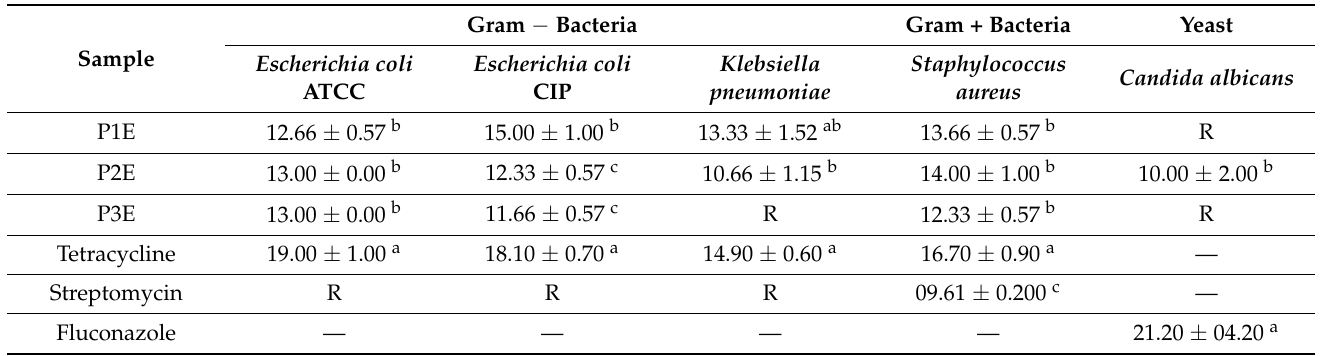
Table 1. Diameter of inhibition zones of P1E, P2E, P3E, tetracycline, streptomycin, and fluconazole in millimeters.